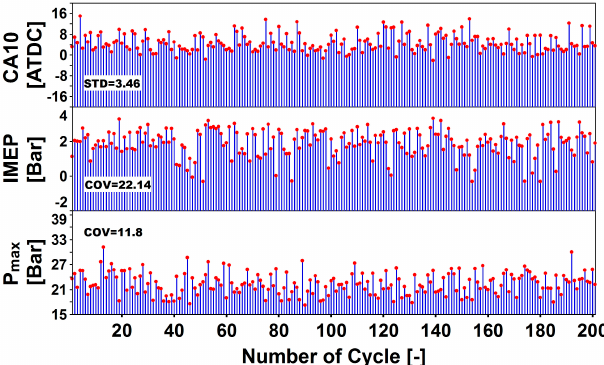
Figure 6. Cyclic variation of CA10, IMEP and P max in conventional operation (rpm = 3000, IMEP = 2.1 bar, T epc = 385 K, In-EGR = 0, Ex-EGR = 0).